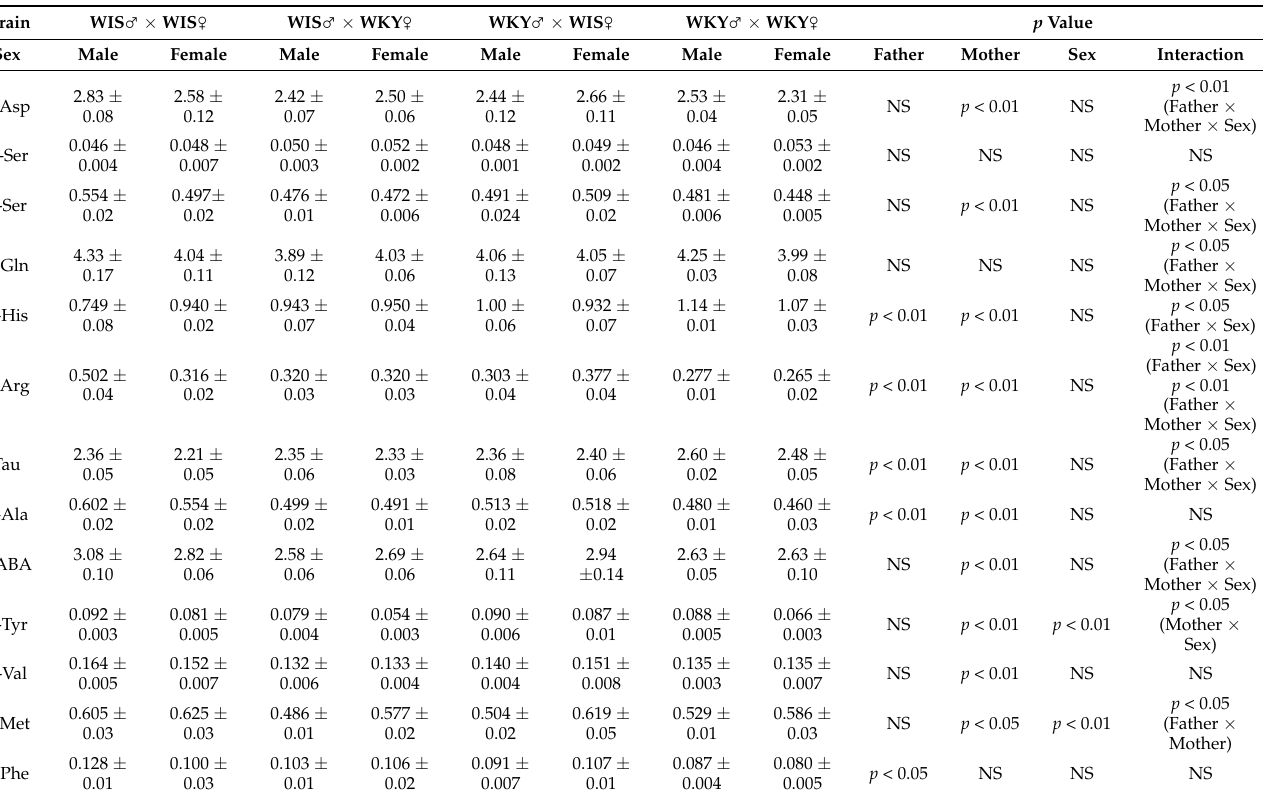
Table 1. Effect of paternal or maternal strain and sex of offspring on free amino acid concentration in the brainstem.